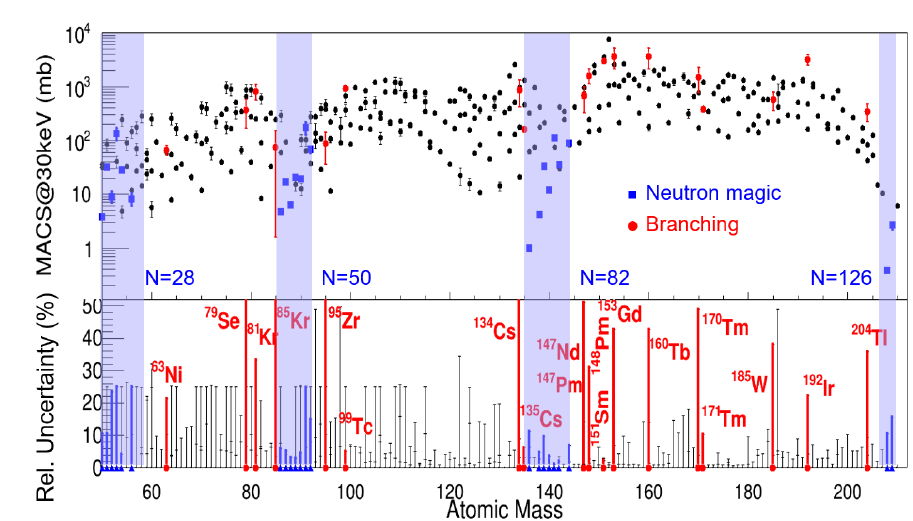
Figure 5. Maxwellian-averaged neutron capture cross section at 30 keV (top panel) and their relative uncertainties (bottom panel). Most values are taken from [42] (see text for